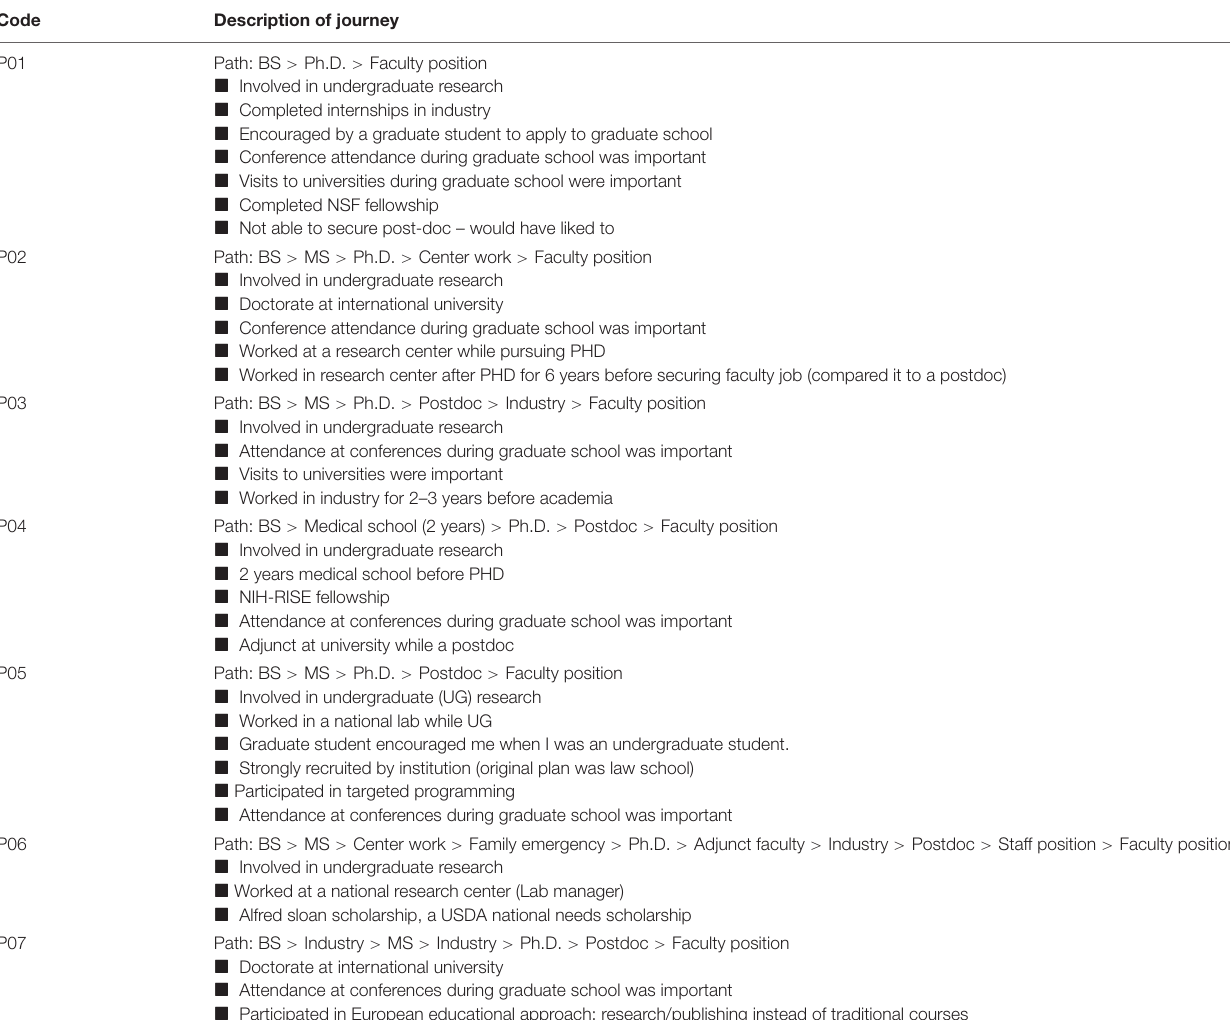
TABLE 2 | Individual journeys: Descriptions of each path to a faculty position. Code Description of